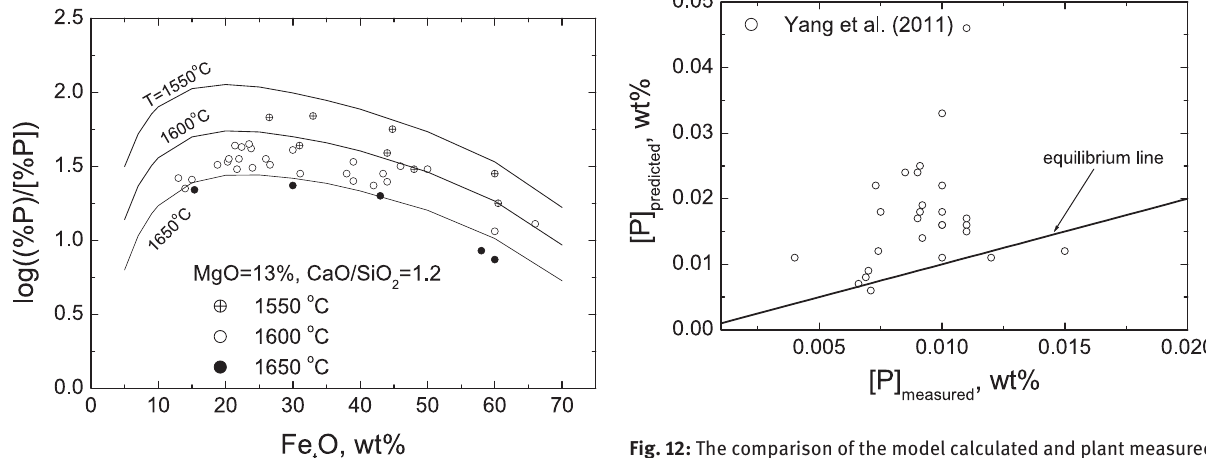
Fig. 9: The effect of FeO content in the slag on the 5 2 5 / FeO P O a γ ratio in the slag.